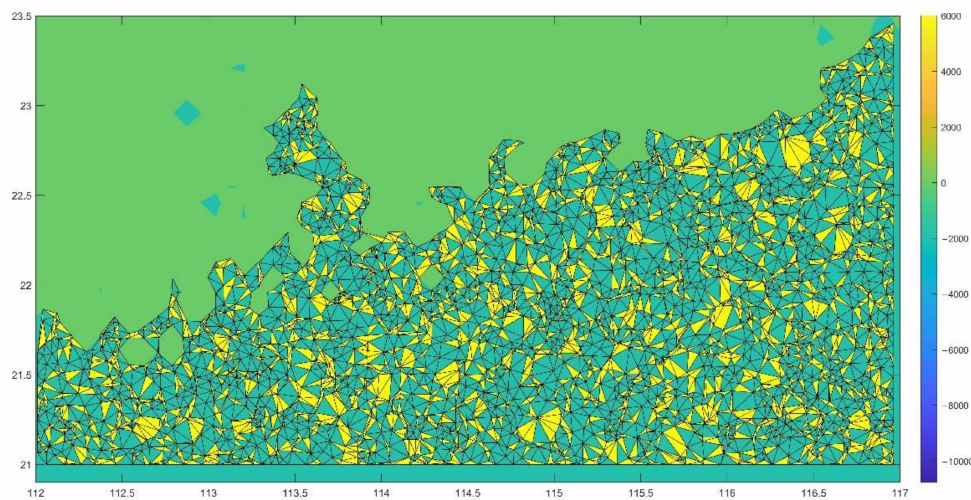
Figure 11. Initial unstructured grid of the inlet range of the South China